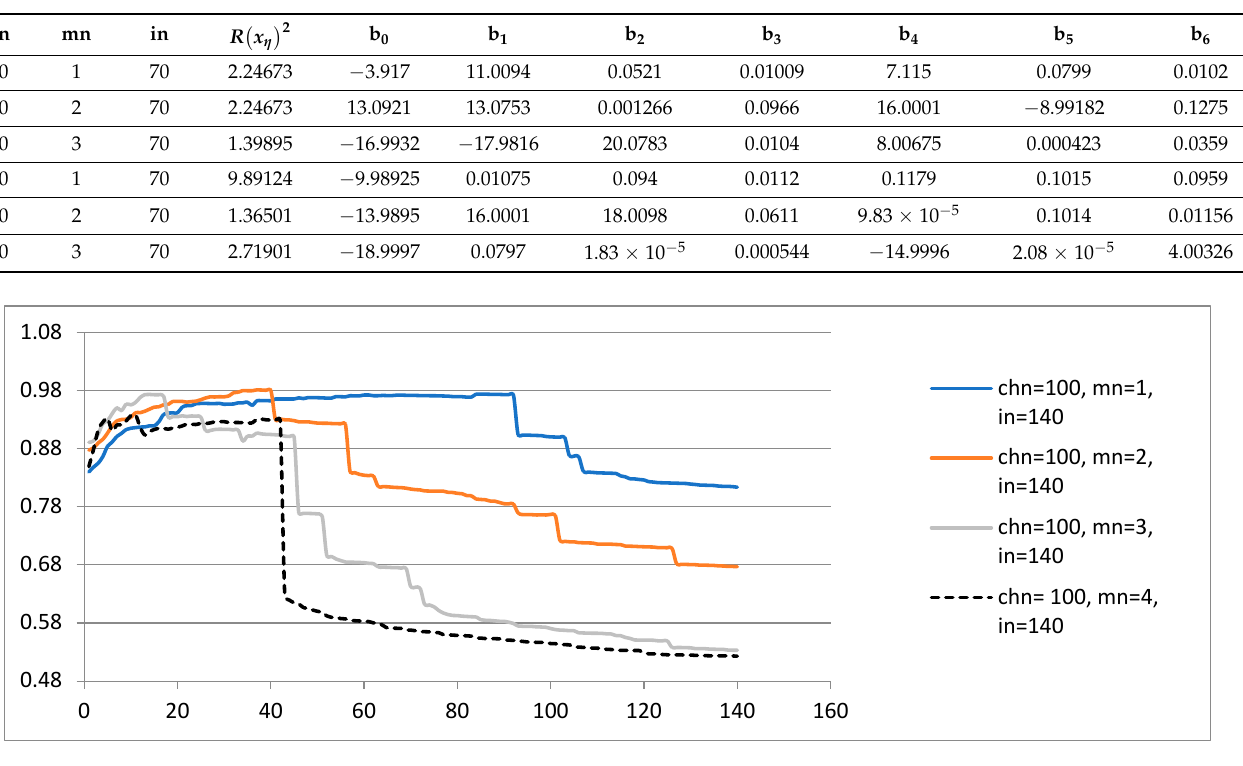
Figure 7. The mean scalar function obtained in each iteration for the simulation described by {chn, mn, in = 140}.